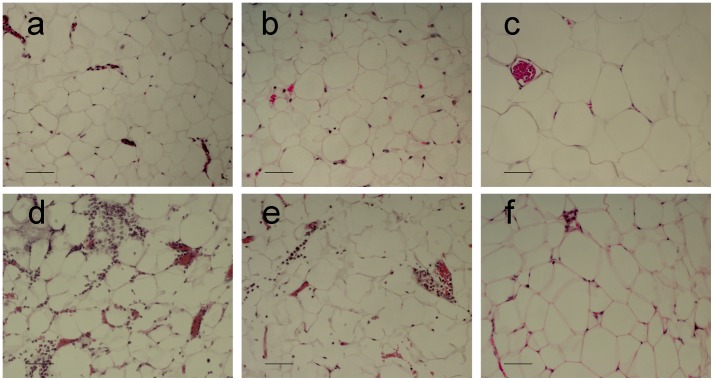
Adipocytes from retroperitoneal areas (c) are higher than that from mesenteric (a) and epididymal (b) regions of adipose tissue.In addition, the number of stromal cells was higher in these regions of adipose tissue. After induction of pancreatitis, an important cell infiltrate could be observed in mesenteric (d) and epididymal (e) areas. By contrast, no relevant infiltrate was observed in retroperitoneal adipose tissue (f).